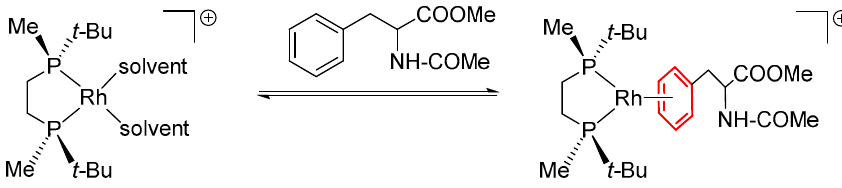
Scheme 12: Equilibrium showing the formation of the rhodium–product complex [Rh( t- Bu-BisP*)( η 6 - mac(H) 2 )]BF 4 following the hydrogenation of mac with [Rh( t- Bu-BisP*)(NBD)]BF 4